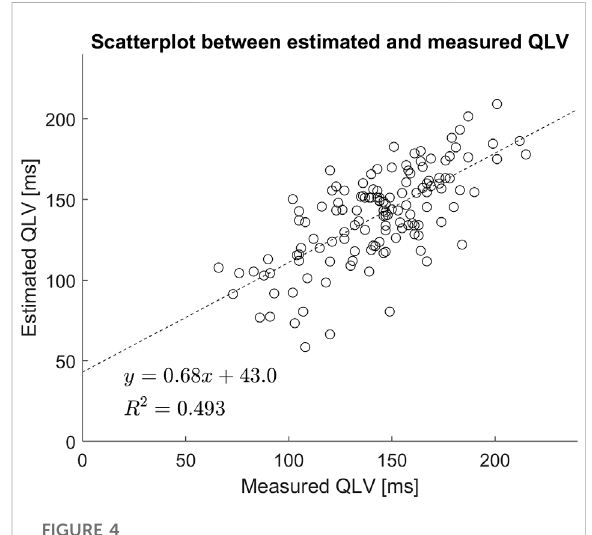
FIGURE 4 Scatter plotof estimated vs.measuredQLV.Included isalso a linear regression